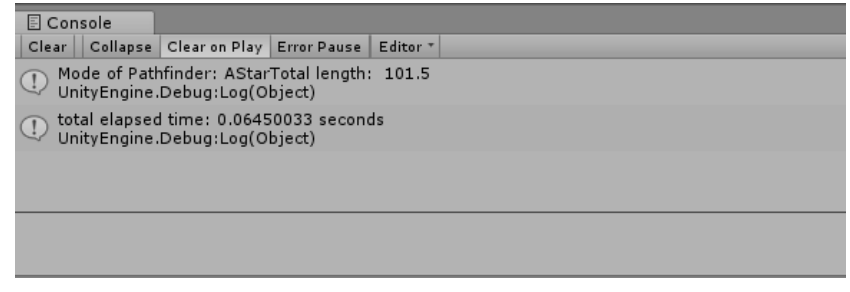
Figure 25. Result using Dijkstra Algorithm (2).